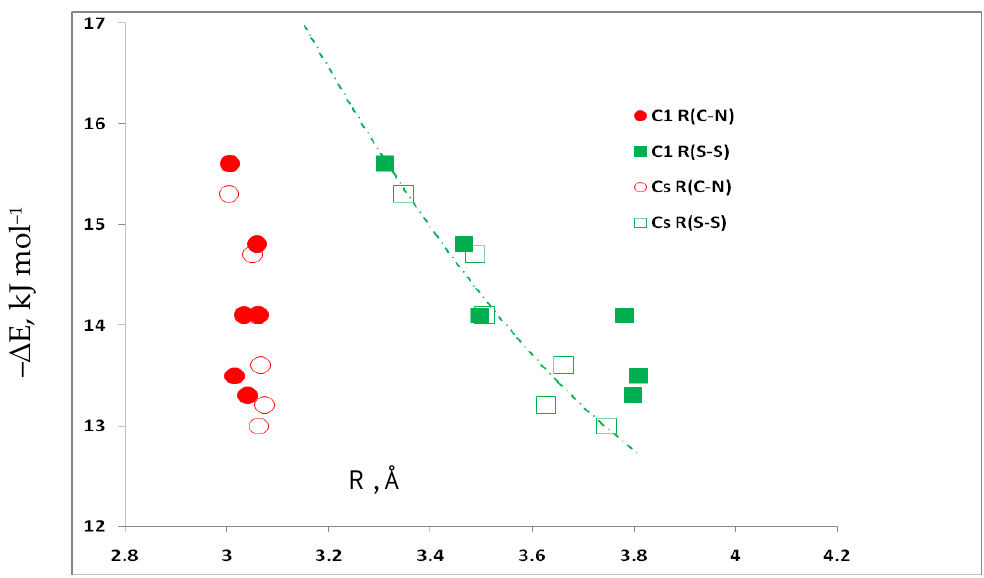
Figure 2. Binding energies of C 1 and C s HN(CH)SX:SCO complexes vs. the N4 – C1 and S – S distances, respectively.